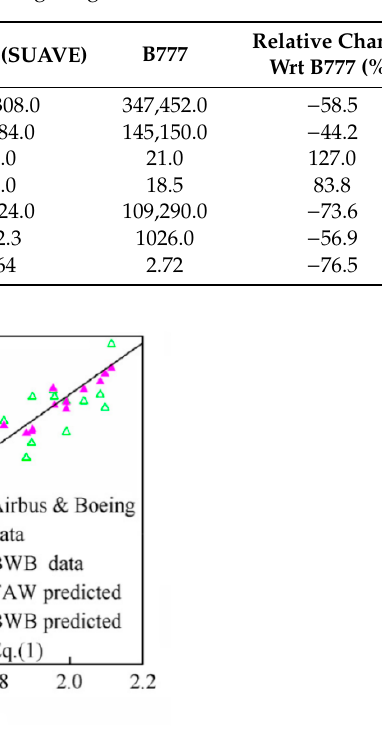
Table 5. Comparison of key aircraft parameters of reference long-range aircraft SE 2 A-LR and B777.